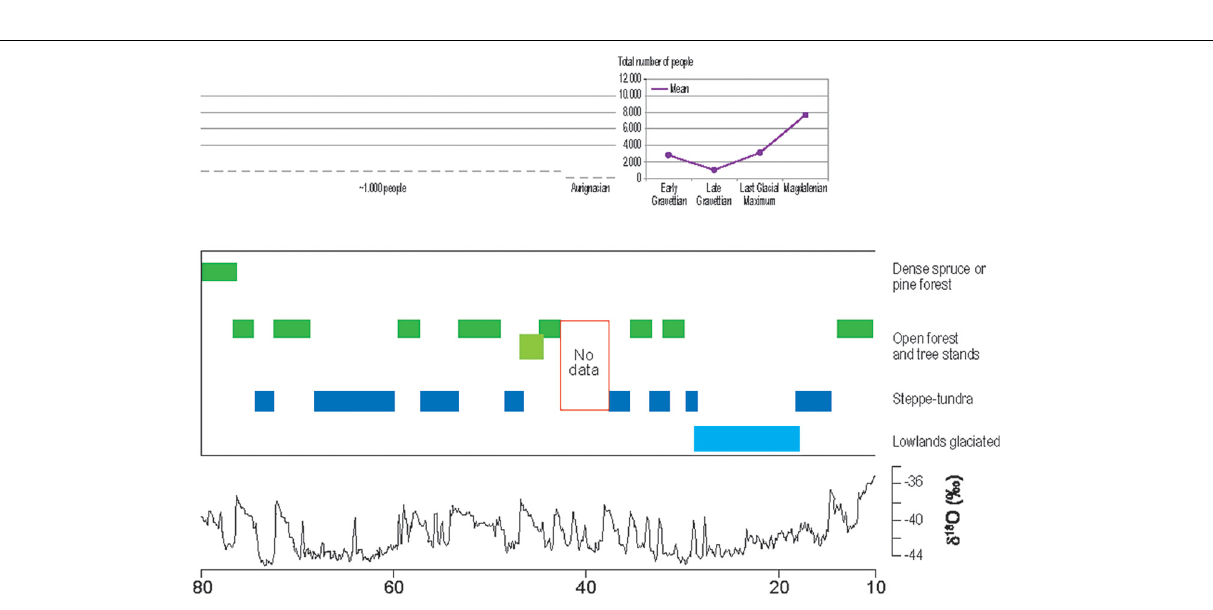
Frontiers in Psychology |